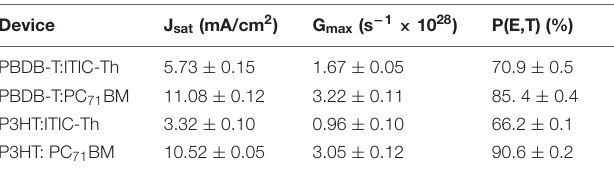
TABLE 2 | Derived saturation photocurrent density, maximum exciton generation rate and charge dissociation and collection probability. Device